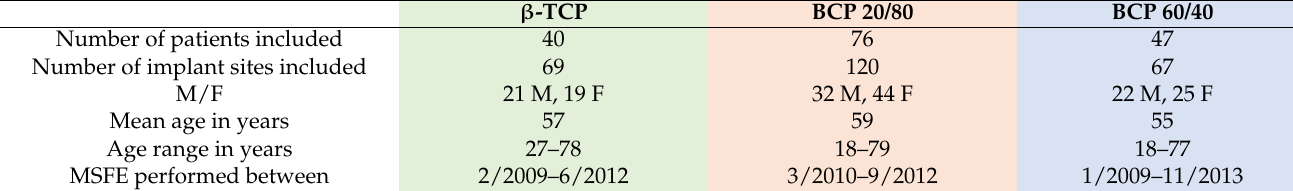
Table 2. Patient data of the three types of calcium phosphate ceramic. β -TCP— β -tricalcium phosphate; BCP—biphasic calcium phosphate; HA—hydroxyapatite; M—male; F—female; MSFE—maxillary sinus floor